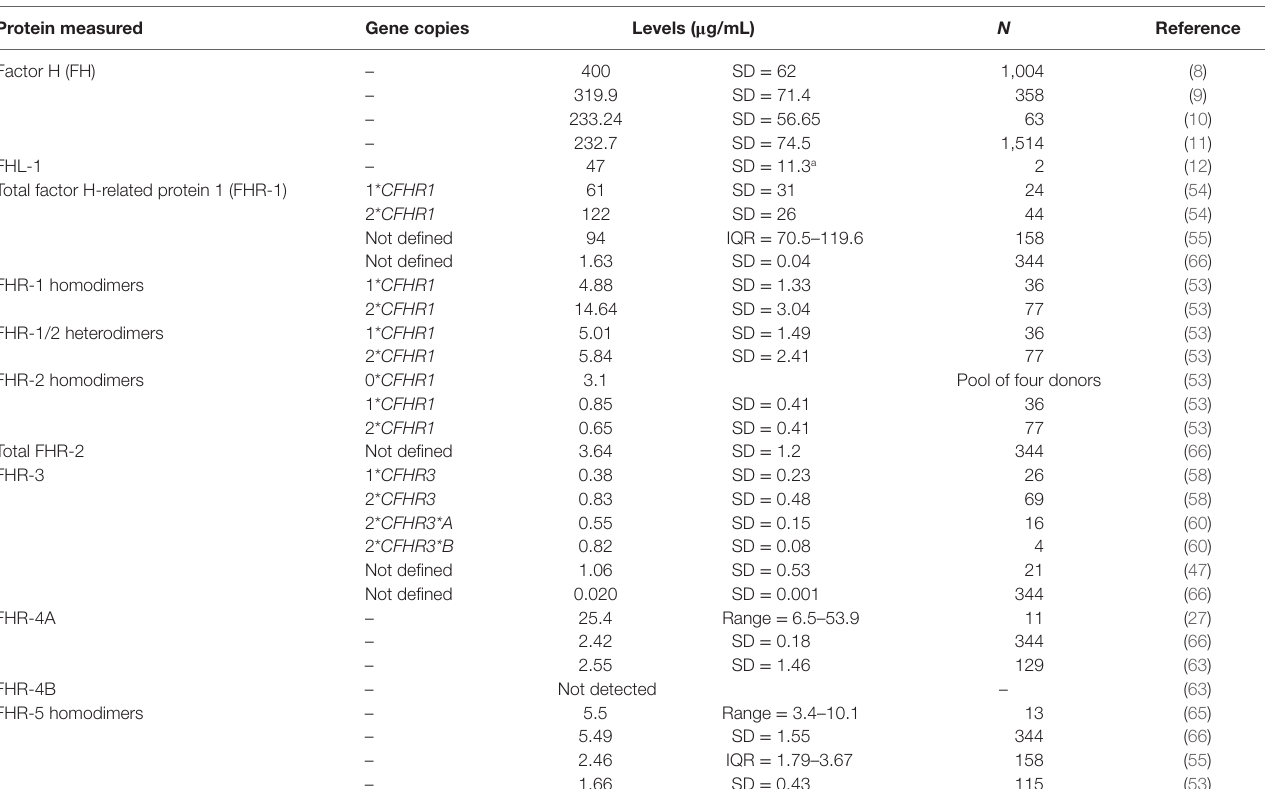
TAble 1 | Reported serum levels of the factor H-related (FHR) proteins. Protein measured gene copies levels ( μ g/ml)